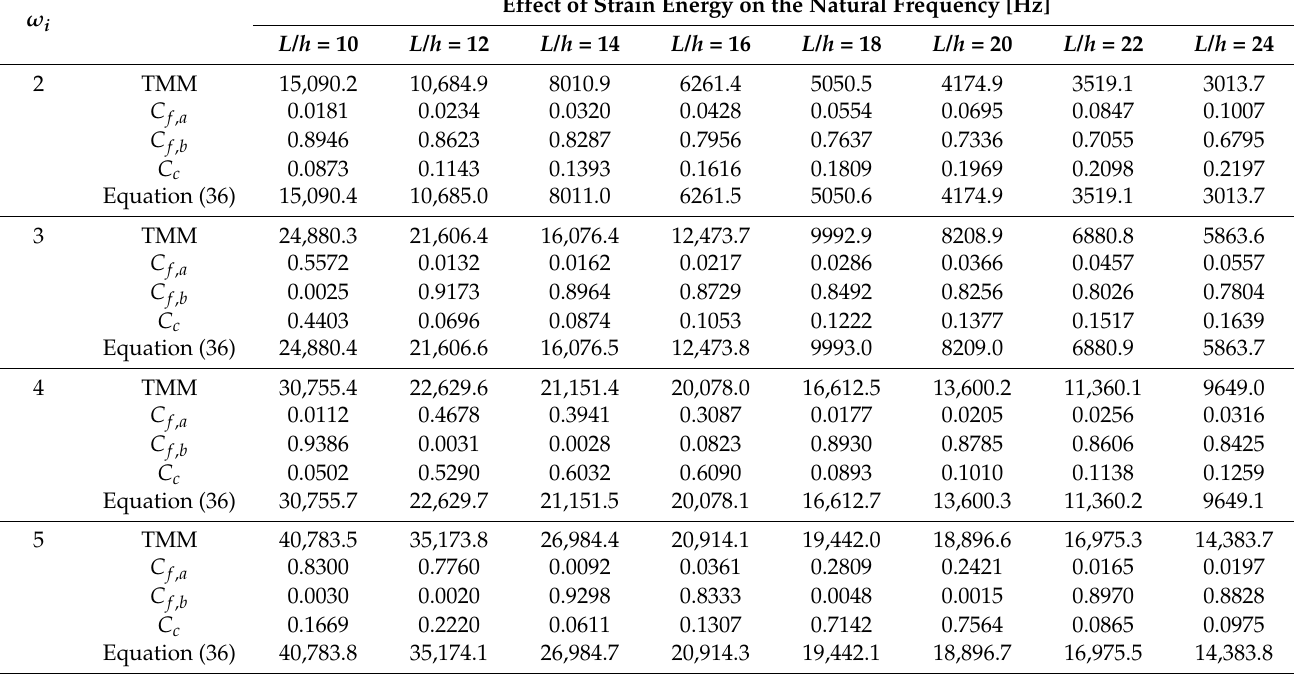
Table 8. Effect of strain energies on the natural frequencies of three-layered beams with the C-P end condition depending on the variation in